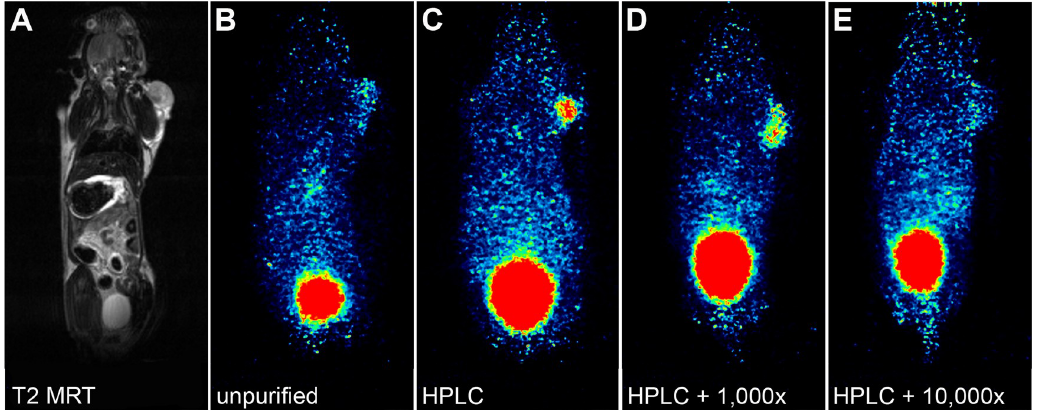
Fig 5. Coronal sections from MRI and PET scans of mice bearing B16/F1 tumors on the right shoulder at 1 h after tail vein injection of 68 Ga-NAPamide with various ratios of labeled and unlabeled peptide. A T2-weighted MRI (corresponding to PET image in B) B unpurified 68 Ga-DOTA-NAPamide C HPLC-purified 68 Ga-NAPamide D HPLC-purified 68 Ga-NAPamide + 1,000-fold excess of DOTA-NAPamide, and E HPLC-purified 68 Ga-NAPamide + 10,000-fold excess of DOTA-NAPamide.